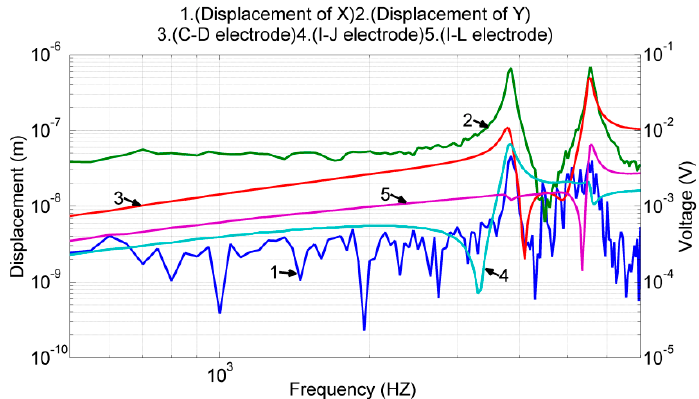
Figure 15. Frequency response of the proof mass displacement and frequency response of the voltage output of the sense electrodes when the device was actuated by the drive electrodes ( A , B ).